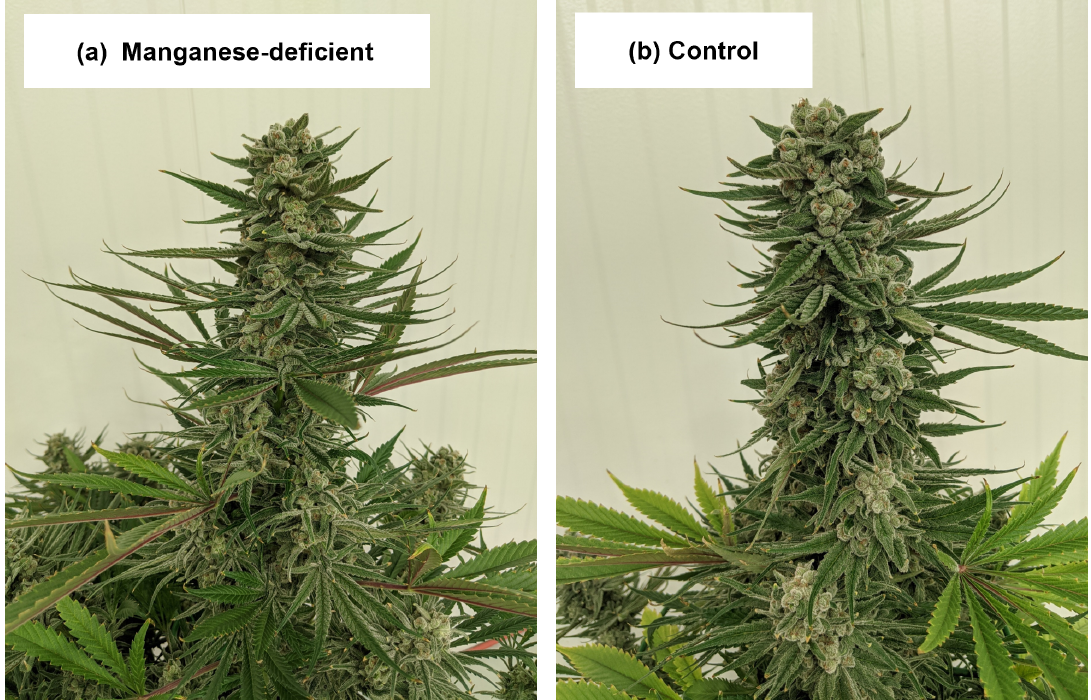
Figure 9. Comparison of apical inflorescence tissues between plants in the manganese deficiency treatment ( a ) and control treatment ( b ) during week seven of the